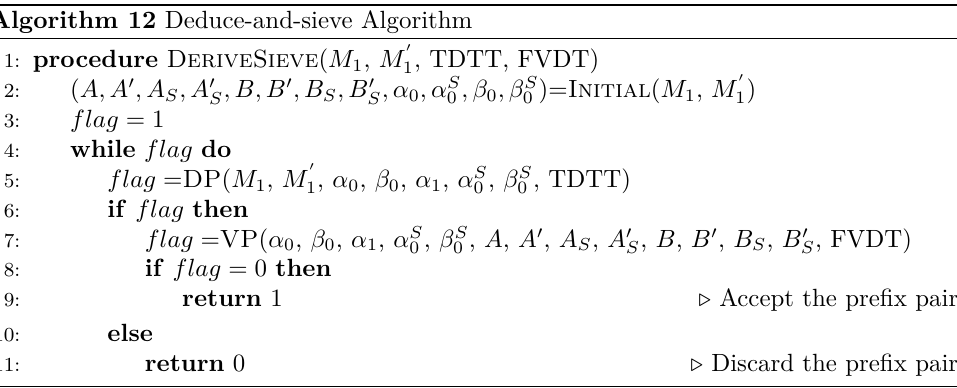
Algorithm 12 Deduce-and-sieve